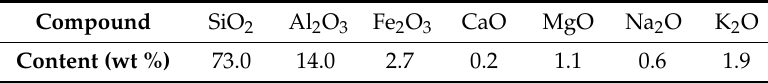
Table 1. Chemical composition of